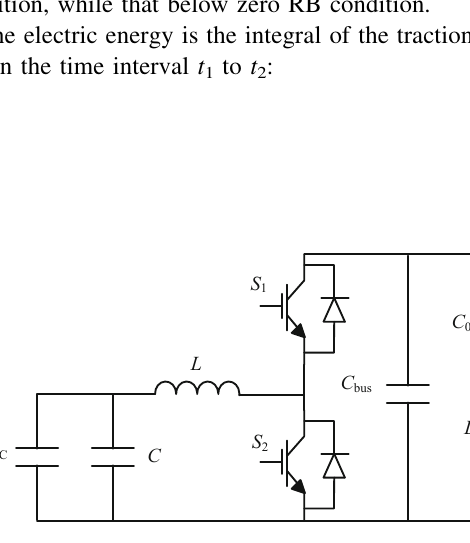
Fig. 3 Boost/buck converter